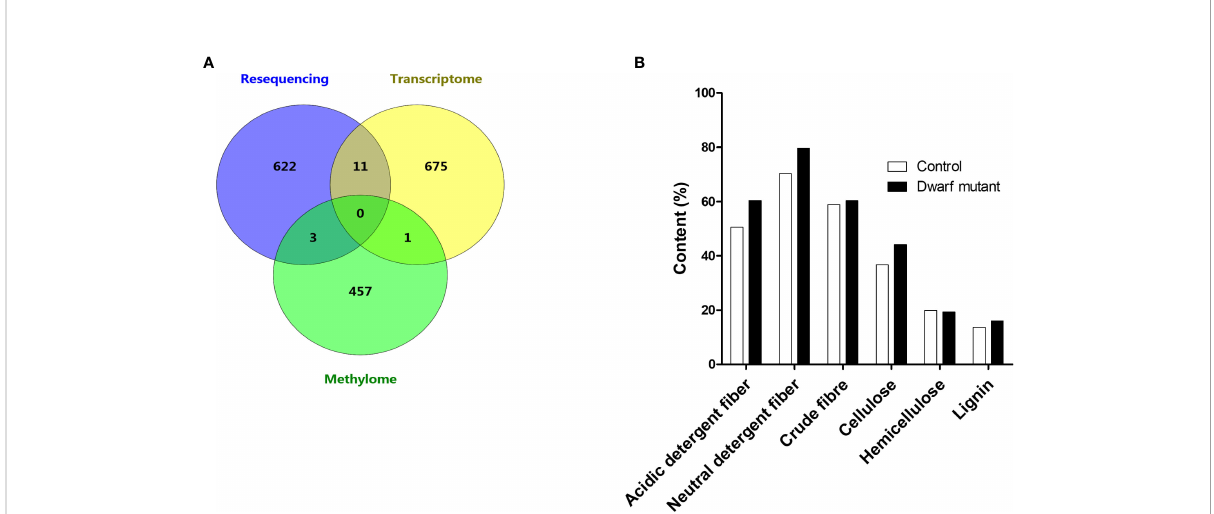
FIGURE 6 Integrative analysis among variants, transcriptome, and methylome. (A) Venn map showing the distribution of genes with nonsynonymous mutation in resequencing dataset, differentially expressed gene in transcriptome dataset and differentially methylated regions in methylome dataset. (B) Comparison of fi ber contents between dwarf mutant and control.